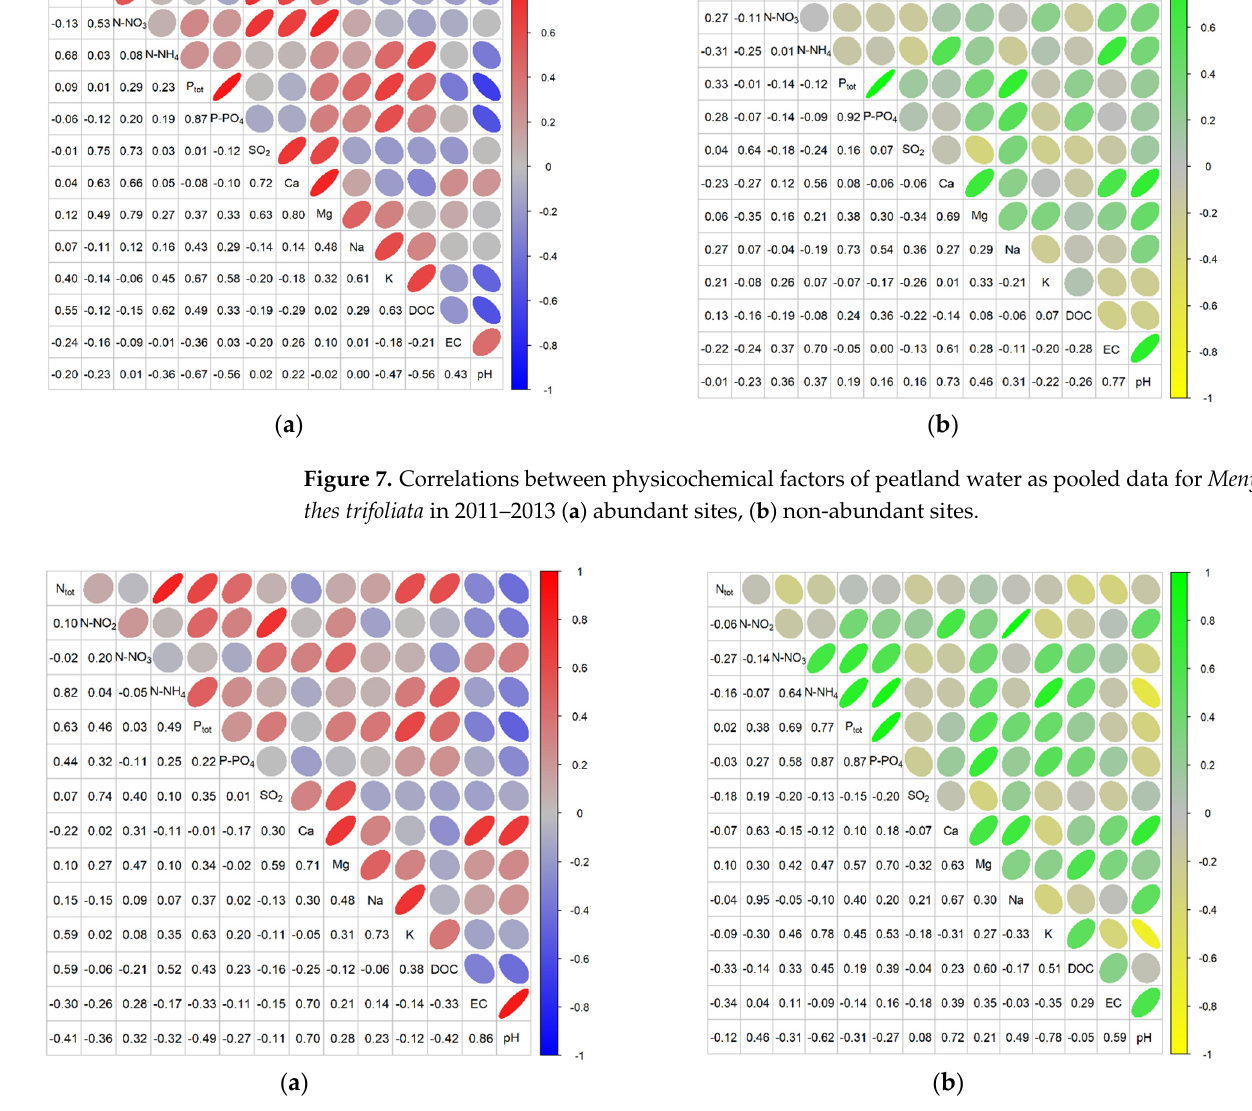
Figure 8. Correlations between physicochemical factors of peatland water as pooled data for Oxy- coccus palustris in 2011–2013: ( a ) abundant sites, ( b ) non-abundant sites.